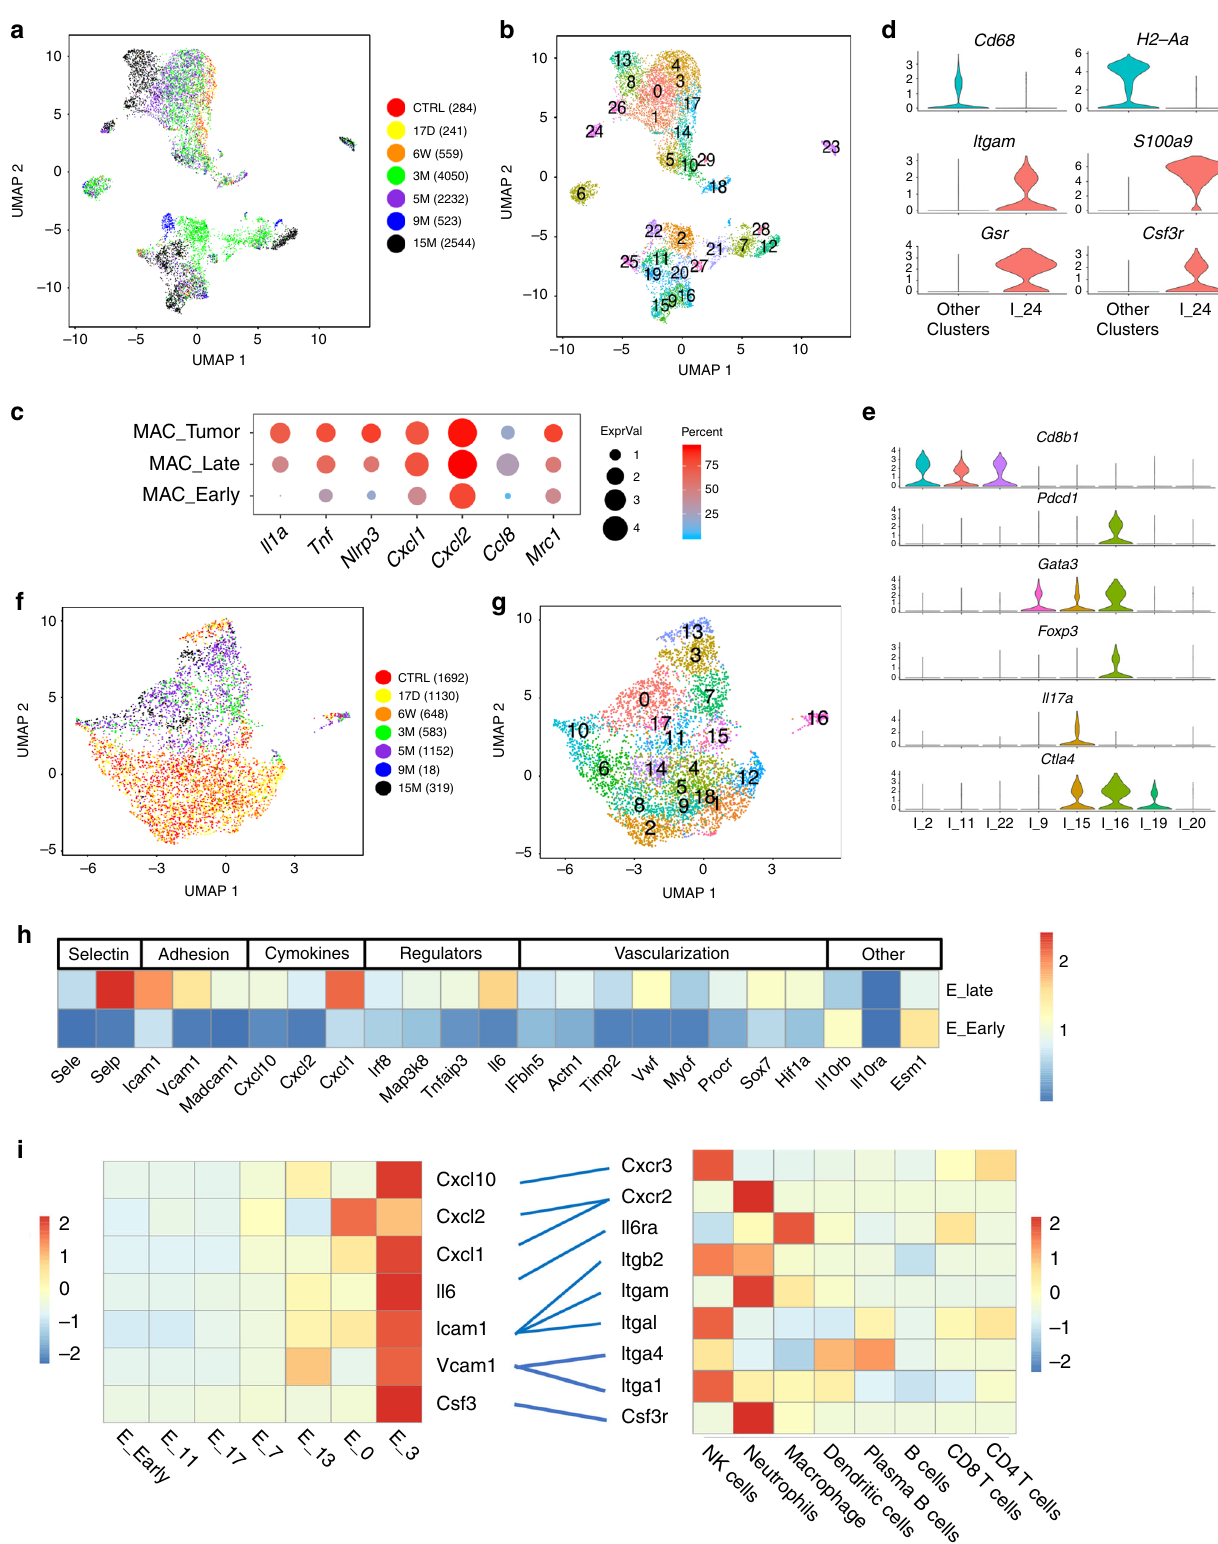
collagen fi ber assembly 59 – 61 ; and collagen production genes (Supplementary Fig. 11c – e). This fi nding is in accordance with one of the major phenomena of PDAC: formation of a desmoplastic microenvironment. At early time points PTI, two clusters of fi broblasts were observed: Igfbp5 + cells (cluster F_6) and Il6 + cells